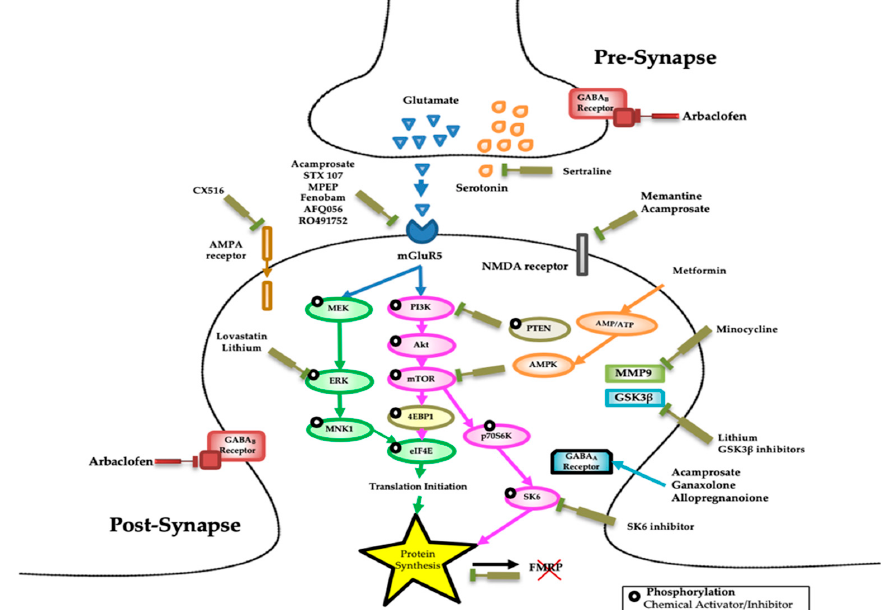
Figure 1. Potential therapeutic targets for fragile X syndrome (FXS). Diagram of the